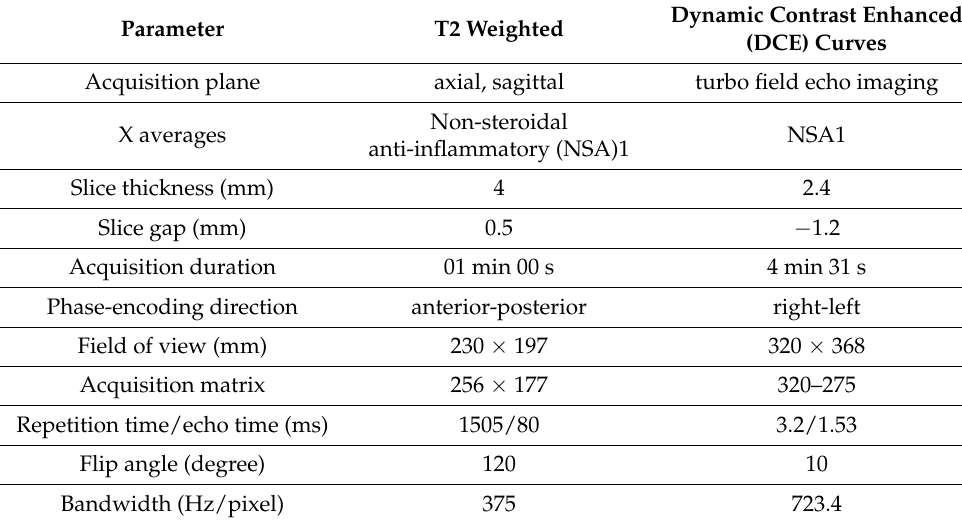
Table 2. Acquisition parameters used in Phillips Sonalleve MR-HIFU